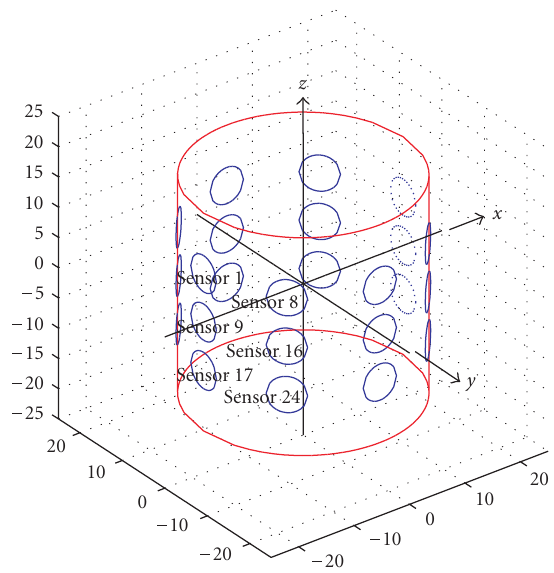
Figure 1: Diagram of the simulated cylinder medium with fluores- cent source and 24 detectors. The center of cylinder was set to co- ordinates (0,0,0). The cylinder has a height of 36 mm and 18mm as base radius. Each detector has a radius of 3mm and centers of 11, re- the sensors are on the z -plane of z = 11, z = 0, and z = (cid:0) spectively. Sensors in three layers are numbered clockwisely (1–8, ) was set in r ( r can be any 9–16, 17–24). The fluorescent source ( (cid:2) location in the cylinder in our